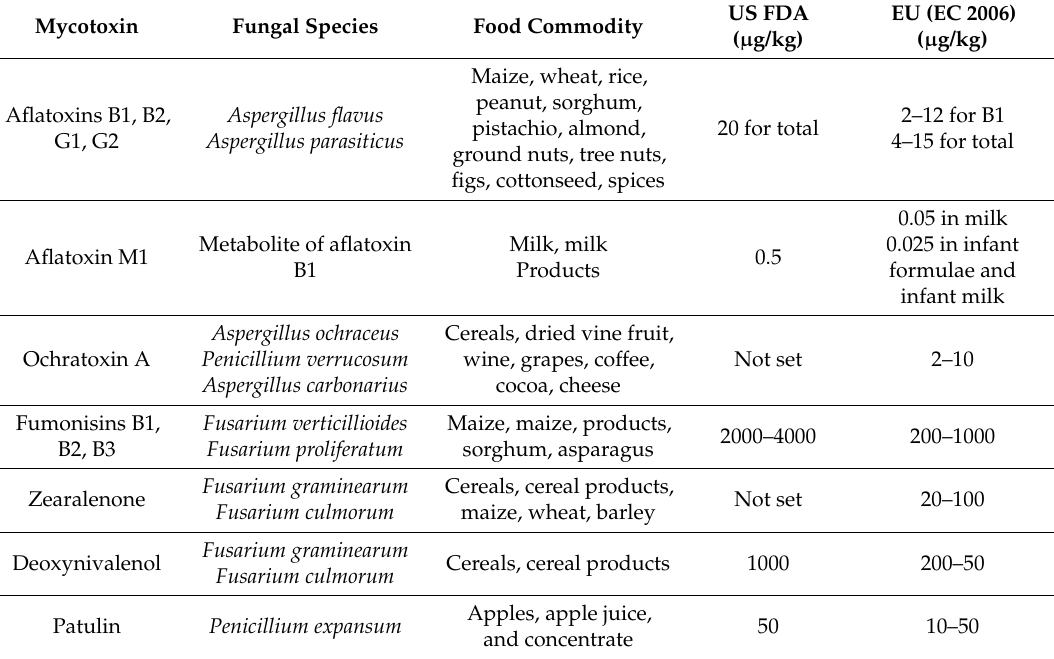
Table 1. Major mycotoxins and US and EU limits on food and animal feed